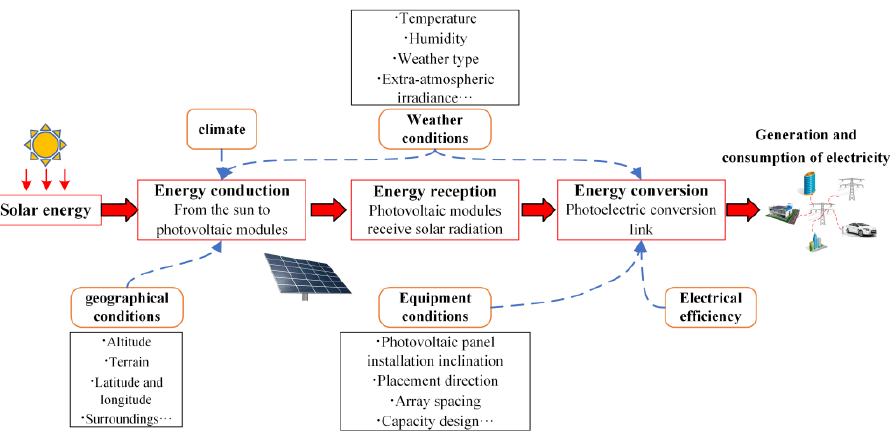
Figure 5. Factors affecting DPVS power output.